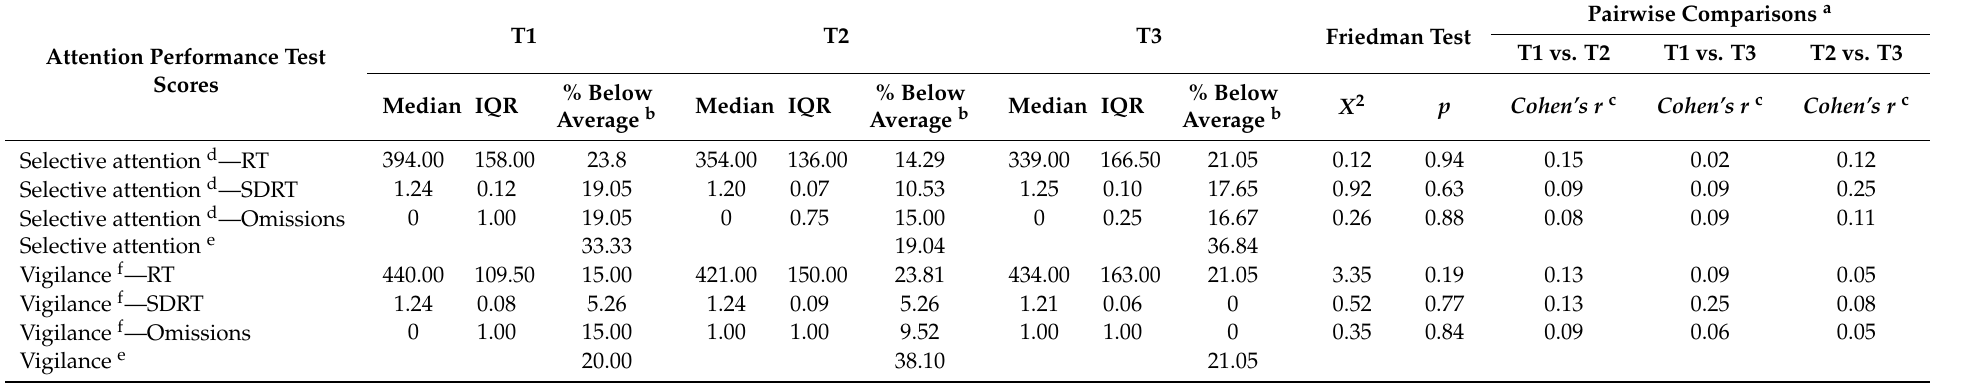
Table 2. Attention performance of individuals with ADHD ( n = 21) across the three assessments T1, T2, and T3.